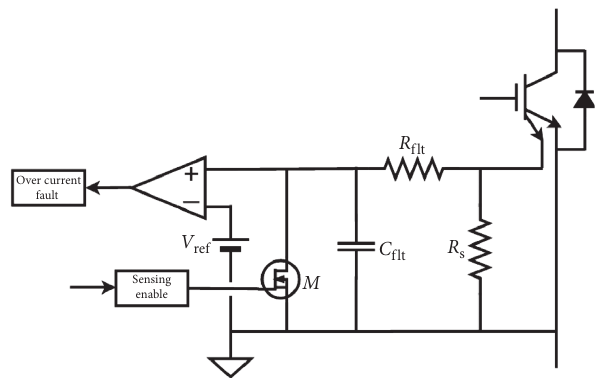
Figure 12: Over-current detection using IGBT internal current